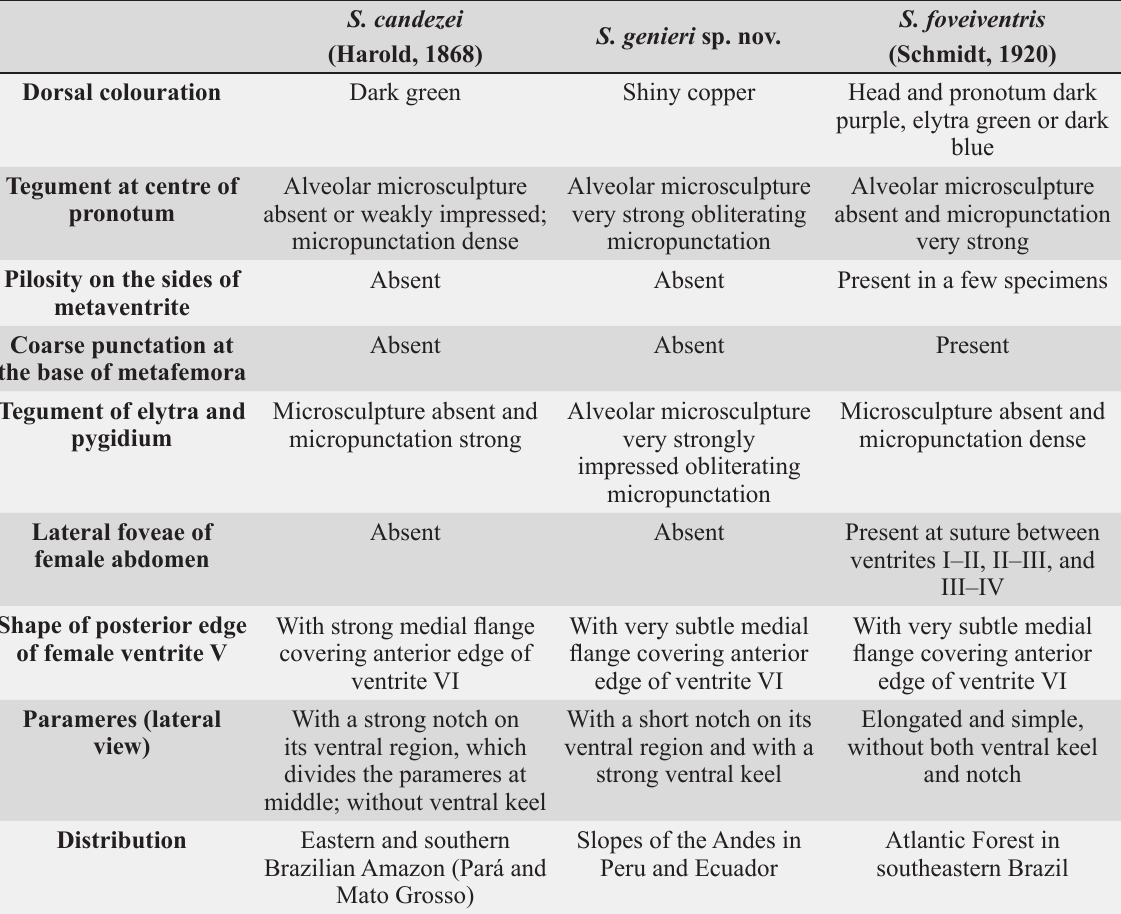
Table 3. Summary of the morphological and distributional differences between the three species of the